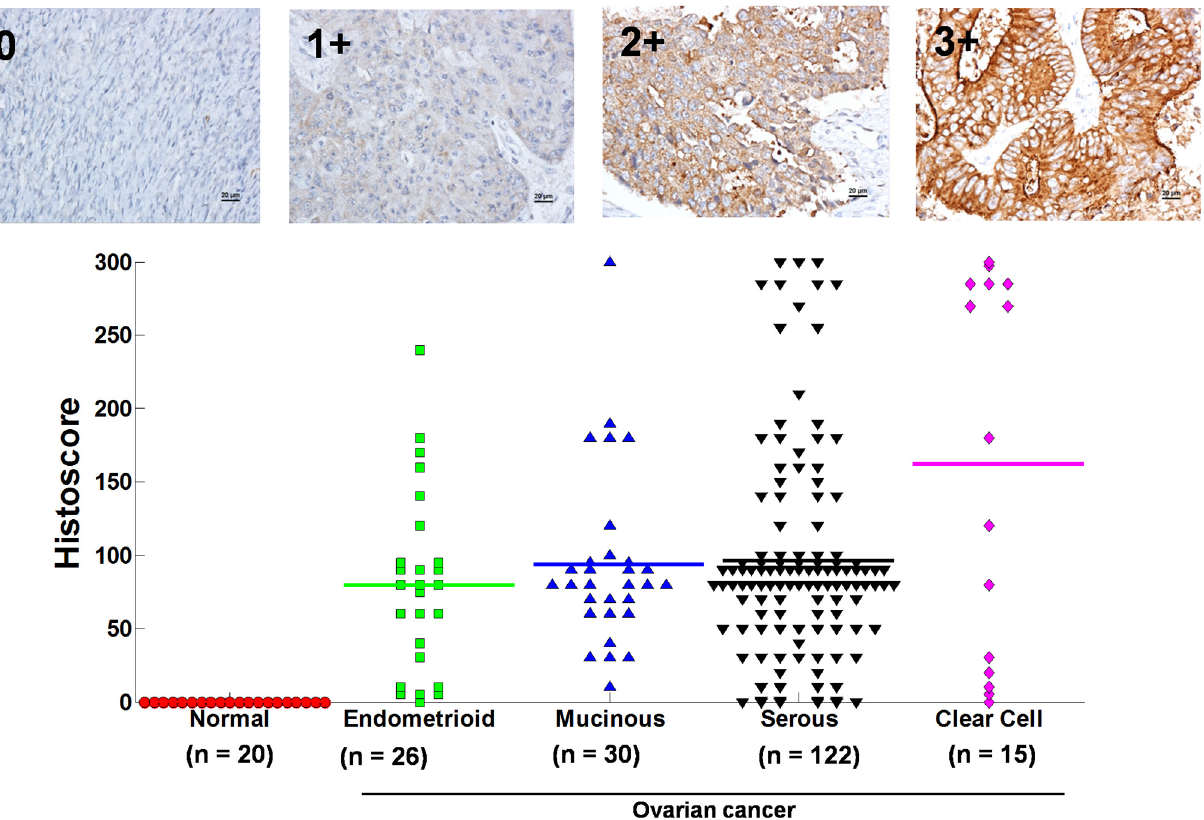
Fig 3. BAIAP2L1 histoscores in different subtypes of ovarian cancer. Immunohistochemical studies were performed on ovarian cancer tissues (n = 193) and normal controls (n = 20). Upper panel indicates the immunohistochemical staining intensity (0 = negative, 1 = weak, 2 = moderate, 3 = strong). The overall immunohistochemical score (histoscore) was the percentage of positive cells multiplied by its staining intensity, and ranged from 0 to 300 (100% multiplied by 3).